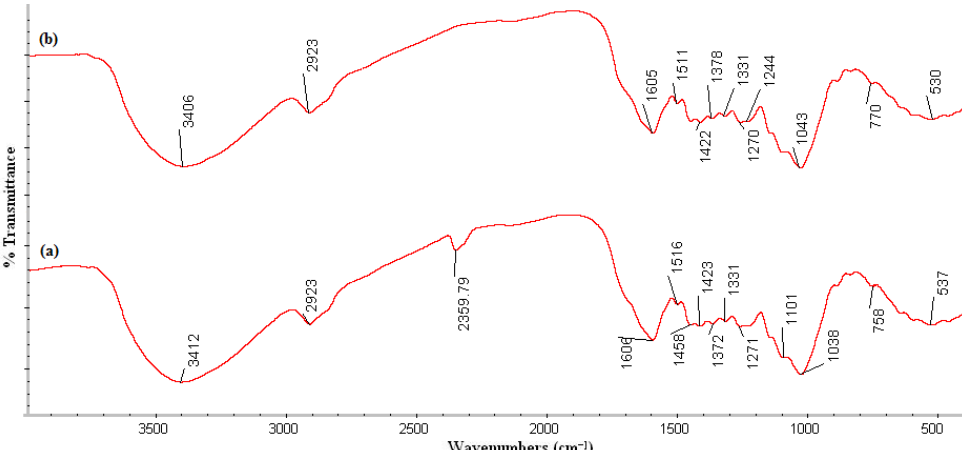
Figure 1. FTIR of PFPB ( a ) prior to and ( b ) after PB dye adsorption.